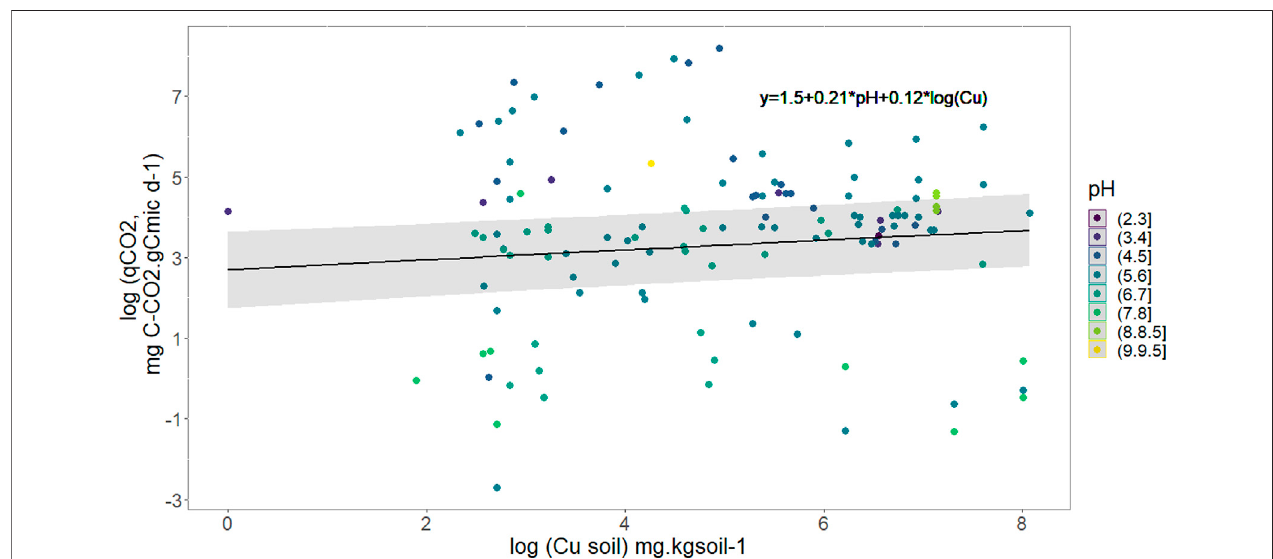
FIGURE 3 | Variation of the metabolic quotient (qCO 2 ) in mg C-CO 2 respired per g of C of soil microbes as a function of soil copper concentration and pH represented through the color of points. The black full line models soil Cu effect on qCO 2 with median pH value (5.7), R 2 (cid:2)